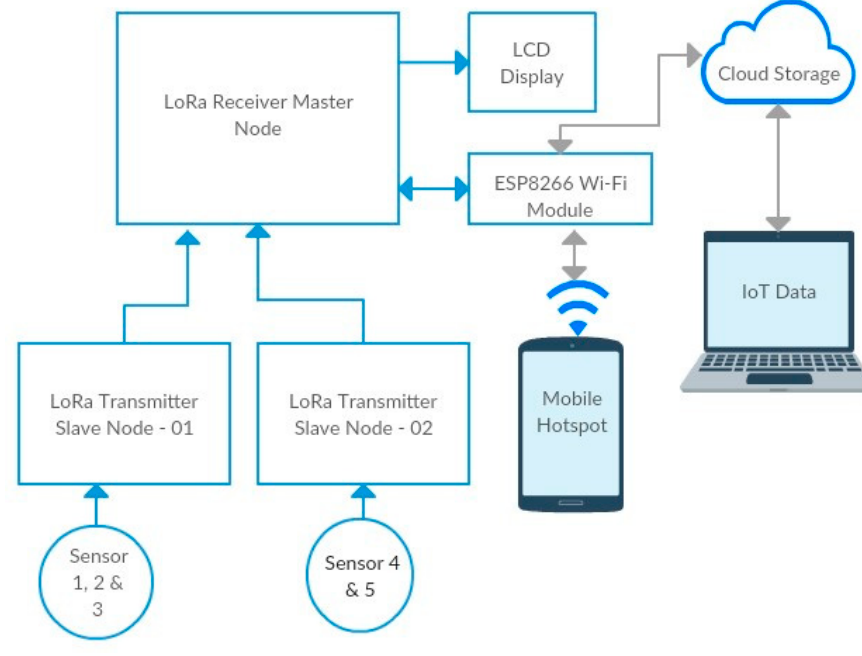
Figure 1. Block diagram of the proposed LoRa transceiver system.